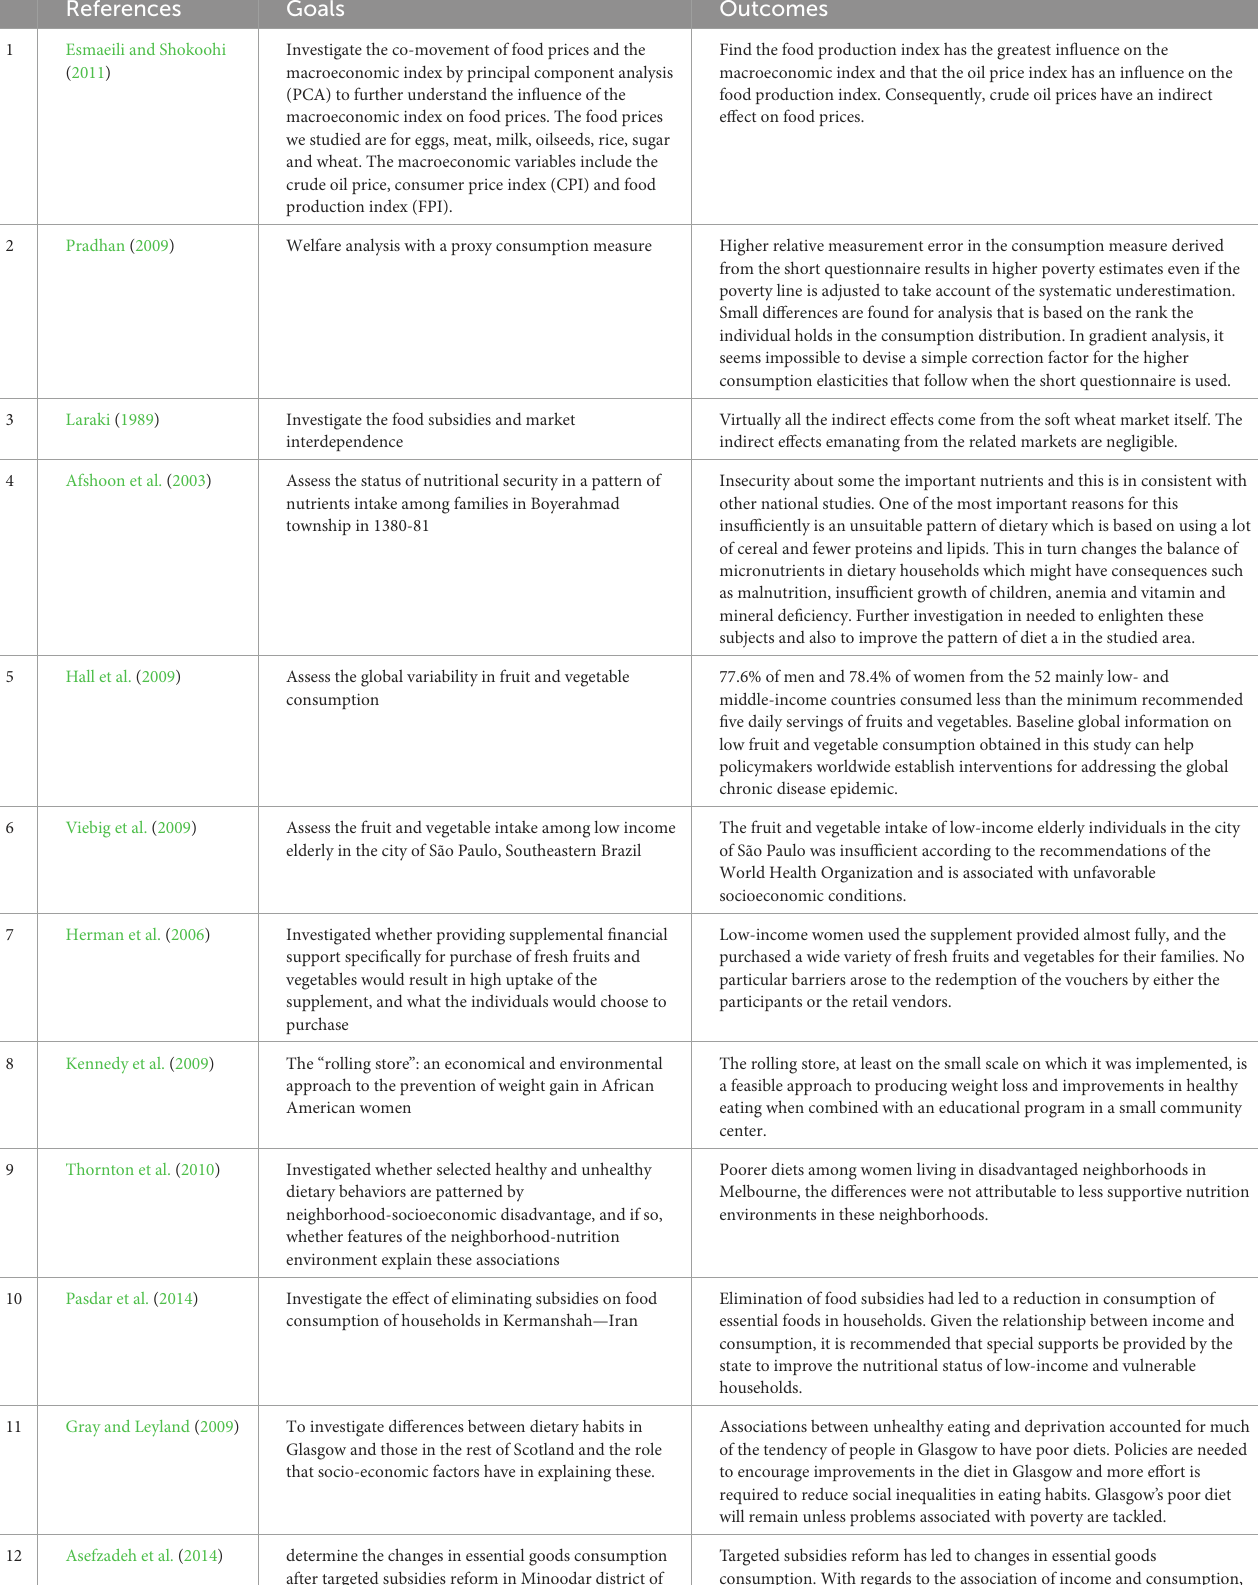
TABLE 1 Summary of studies included in a review of field experiments on the effects of subsidies on food in Iran and its role on individual nutritional